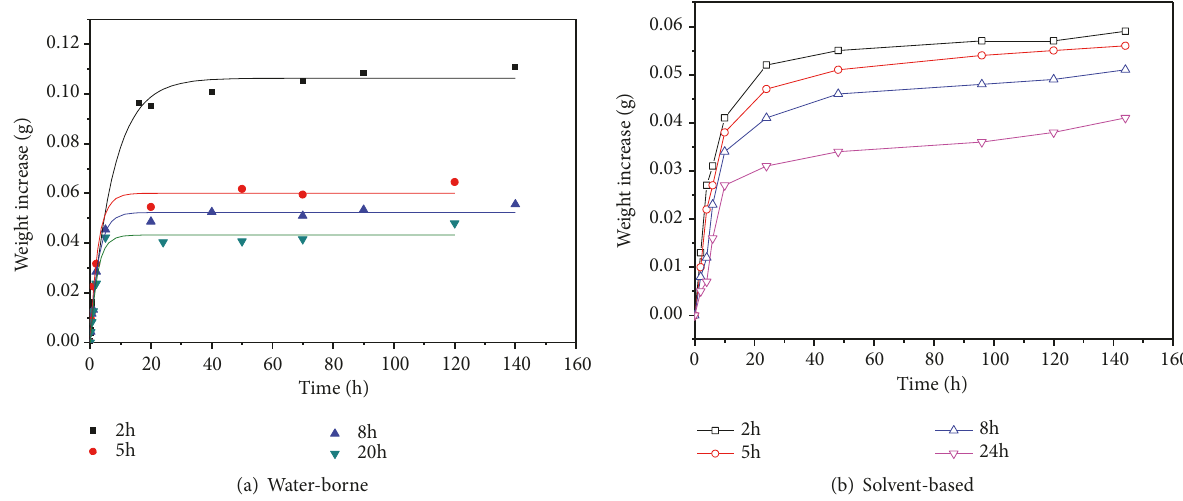
Figure 5: The water absorption rates of the P(BA/St) films for different formation times at room